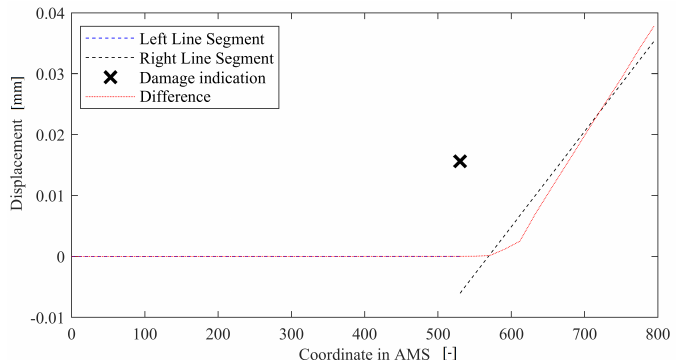
Figure 7. Example of operation of the LS